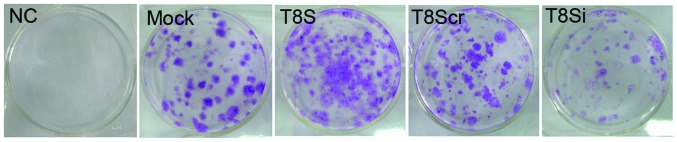
Colony-formation assay was performed in 6 cm dishes and images of cell colonies were captured (magnification, ×40).